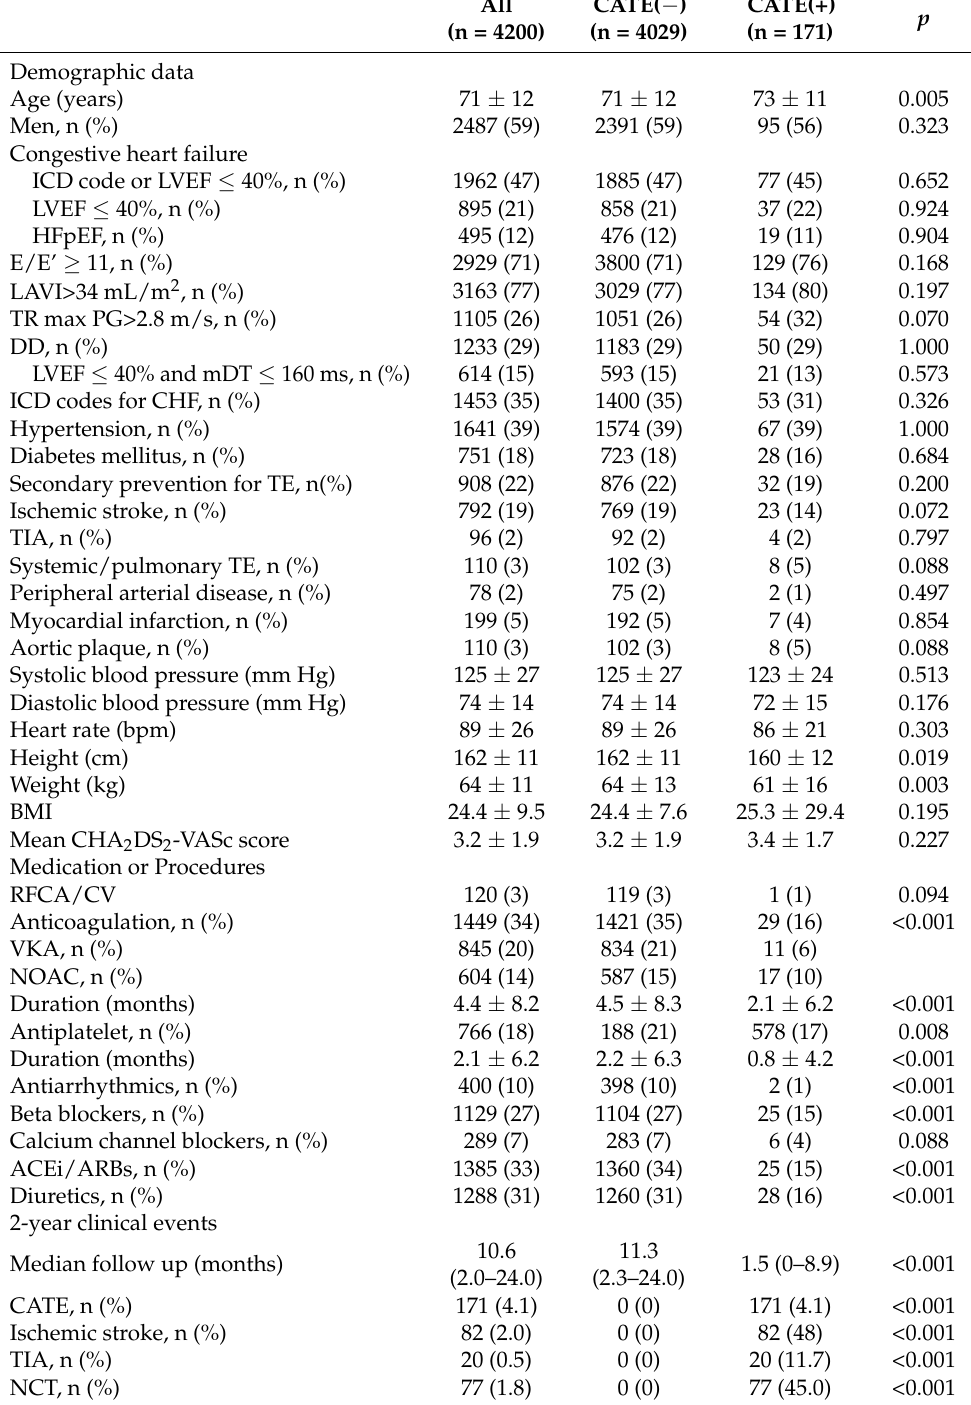
Table 1. Baseline characteristics and outcomes of total